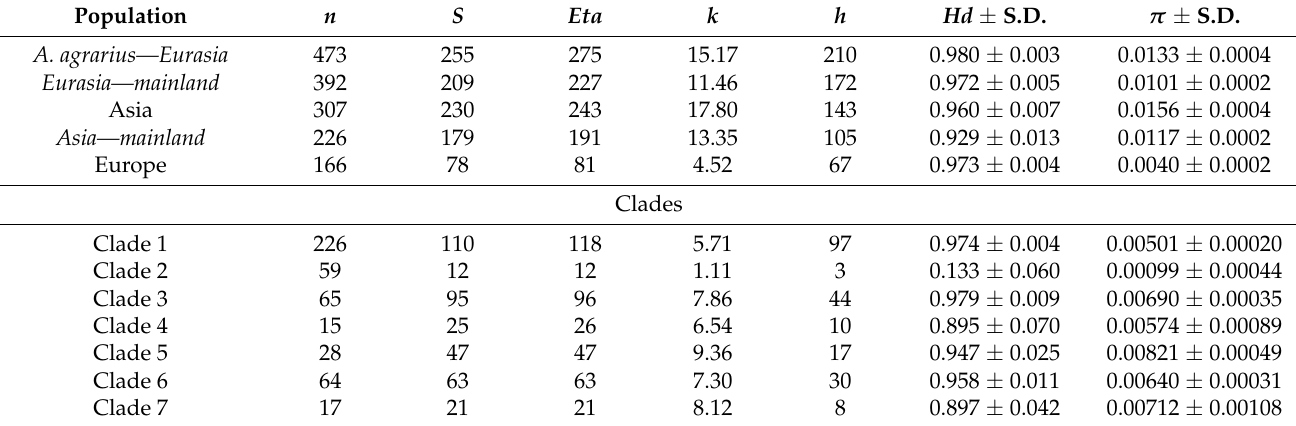
Table 1. The genetic diversity indices of mtDNA (cyt b) of the populations and identified phylogenetic clades; n —number of sequences, S —number of segregating sites, Eta —total number of mutations, k —average number of differences, h —number of haplotypes, Hd —haplotype diversity, π —nucleotide